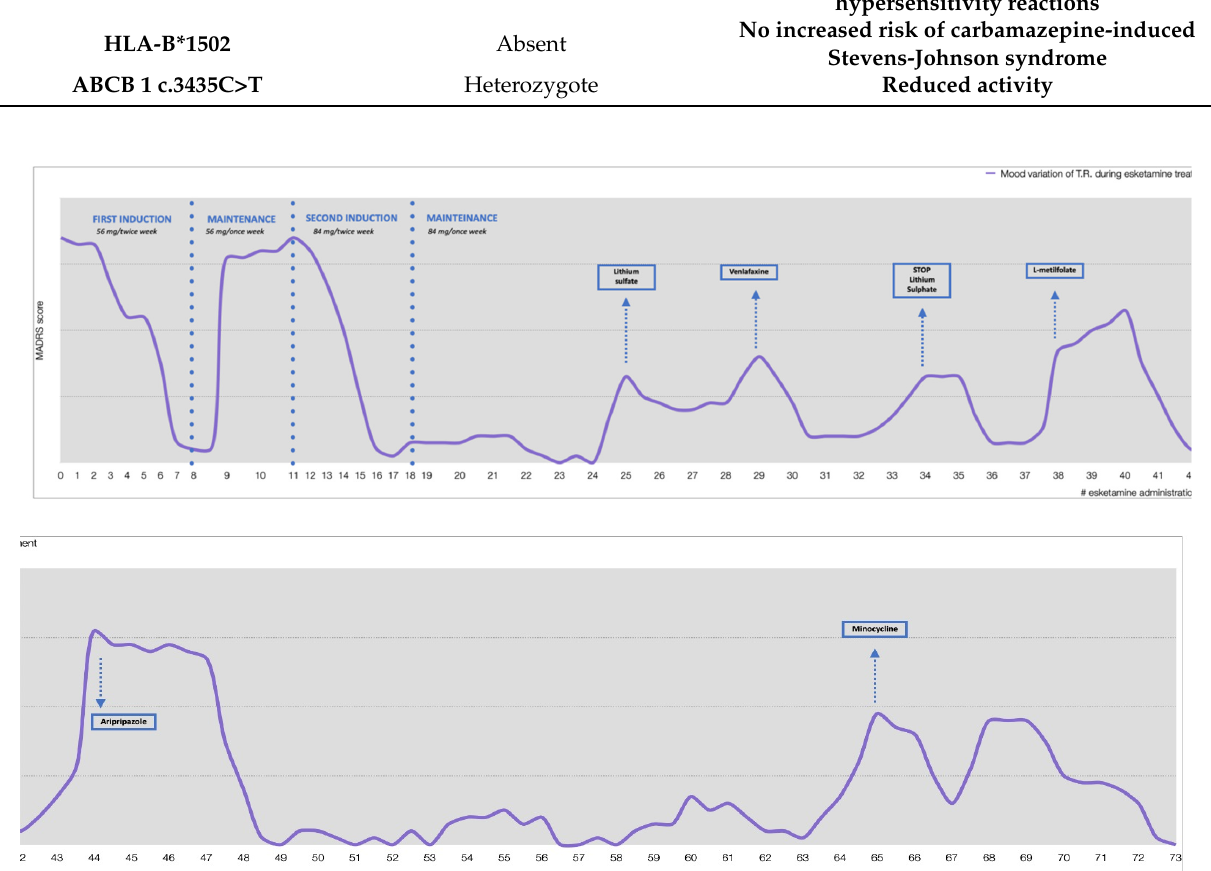
Figure 2. Mood variation and pharmacologic modulation during esketamine treatment .